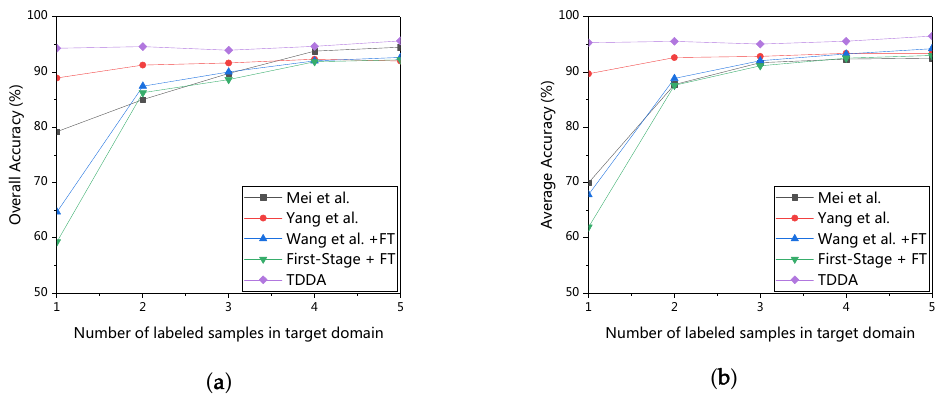
Figure 13. The classification results of different methods with different labeled samples in target domain on Hangzhou → Shanghai dataset. (a) OA. (b) AA.